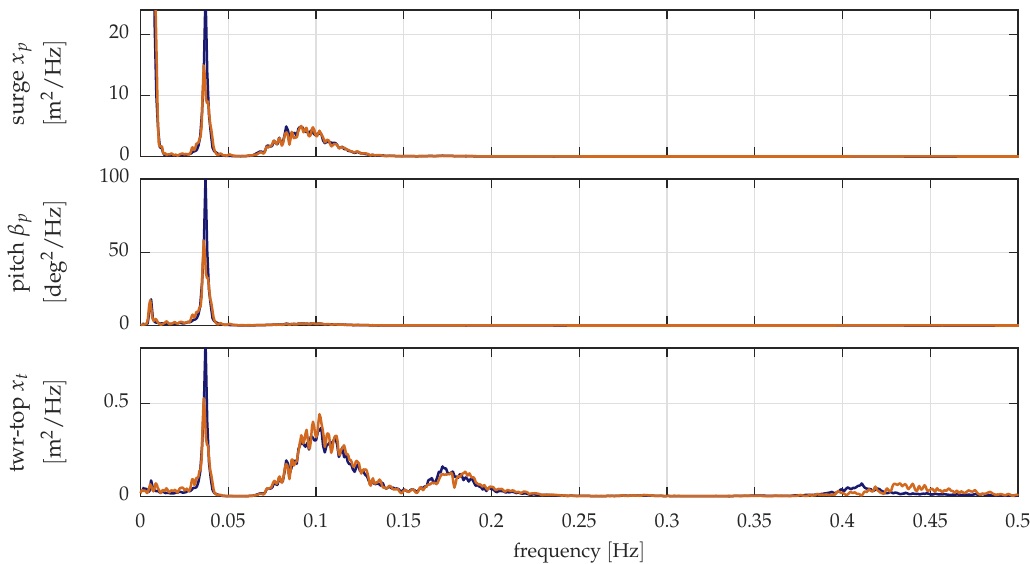
Figure 12. Model verification: Power Spectral Density (PSD) of response to LIFES50+ operational LC of Table 2 at wind speed v = 17.9m/s ( H s = 4.3m, T p = 10s). Linearized SLOW model (dark blue), FAST (light